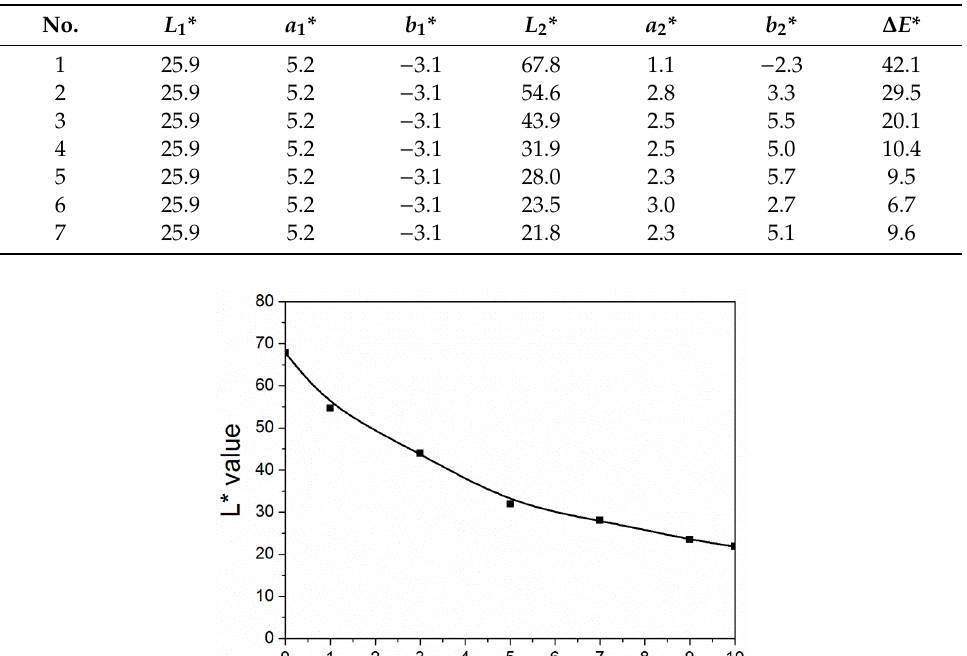
Figure 1. E ff ect of black paste content on gloss of the coatings. Figure 1. Effect of black paste content on gloss of the coatings.